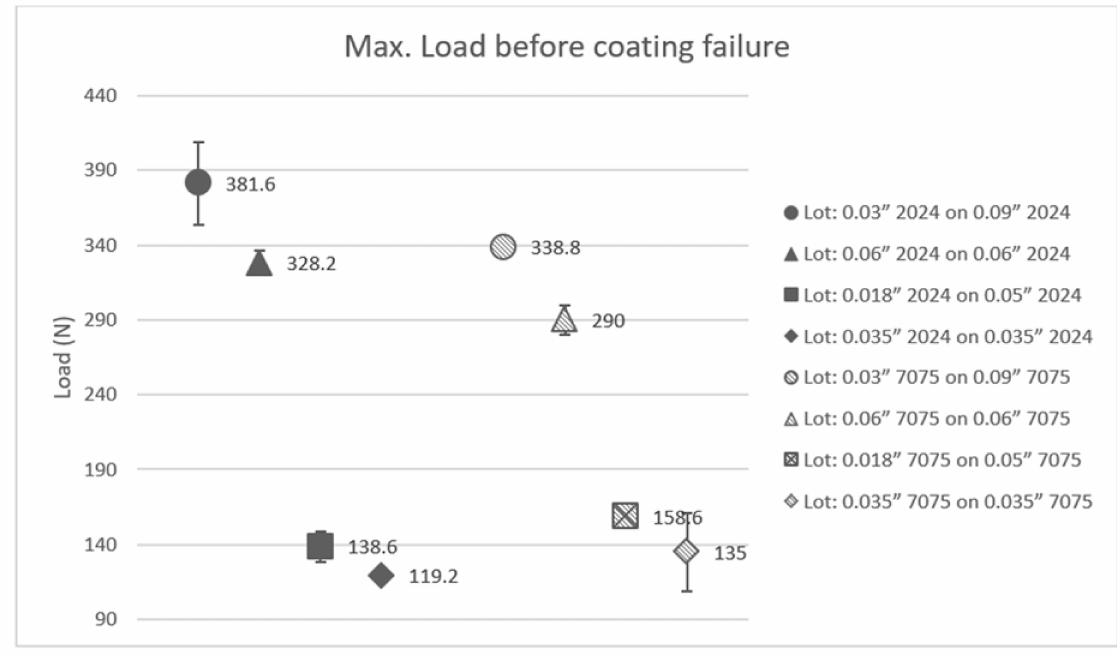
Figure 16. Averaged maximum load on the coating before coating